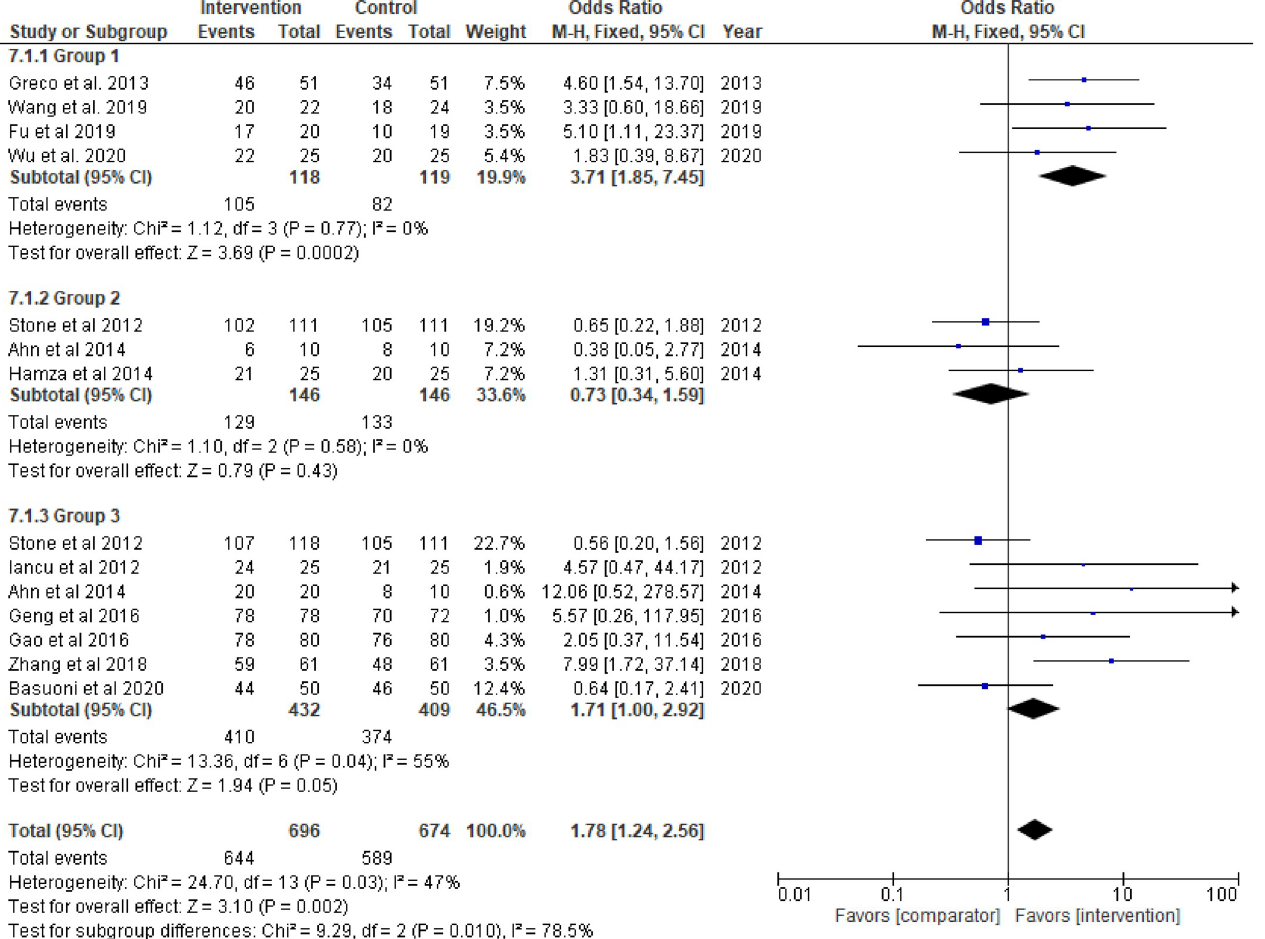
Fig 3. TIMI flow grade 3. Group 1: Thrombolytic agent; Group 2: Glycoprotein IIb/IIIa inhibitors (GPI); Group 3: GPI plus aspiration thrombectomy.